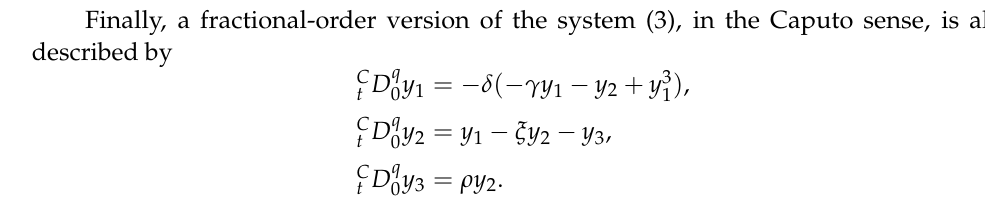
Figure 2. The bifurcation diagram of system (3) using γ = 0.1, δ = 100, ρ = 200 and with initial conditions [ − 0.4, 0.02, − 0.3 ] T